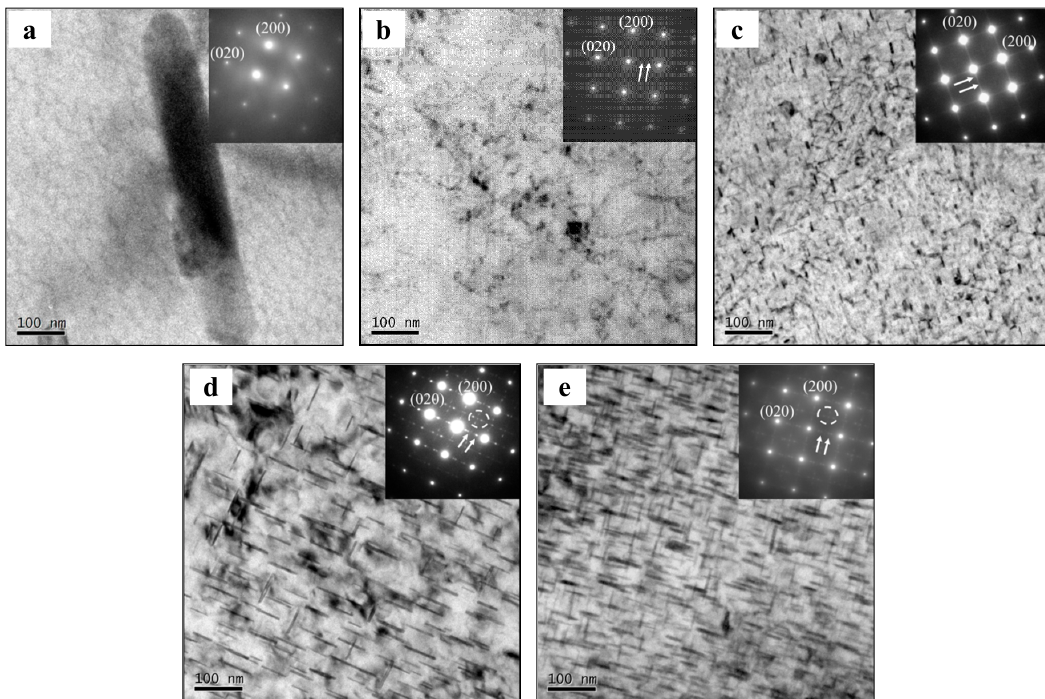
. ε = 0.0003 s − 1 ; and ( e )